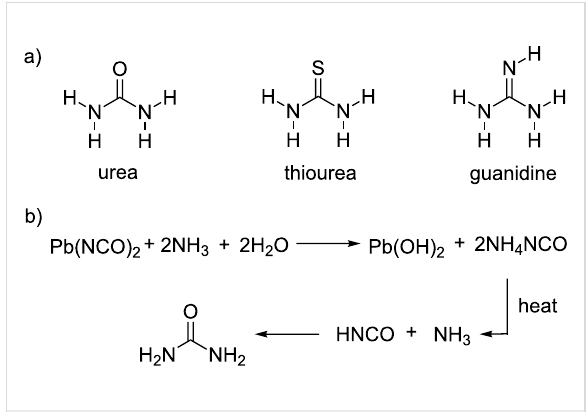
Scheme 1: a) Schematic representations of unsubstituted urea, thio- urea and guanidine. b) Wöhler's synthesis of urea.